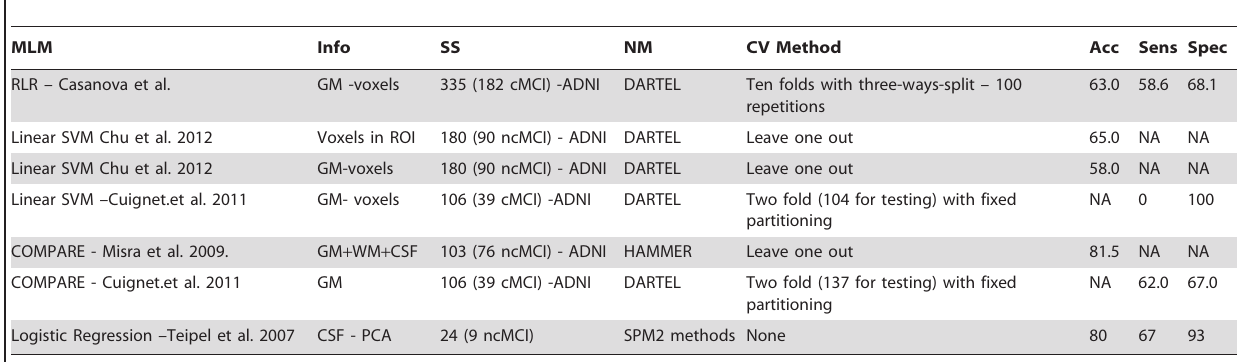
Table 9. Summary of classification reports of ncMCI versus cMCI subjects based on structural MRI data from different groups.